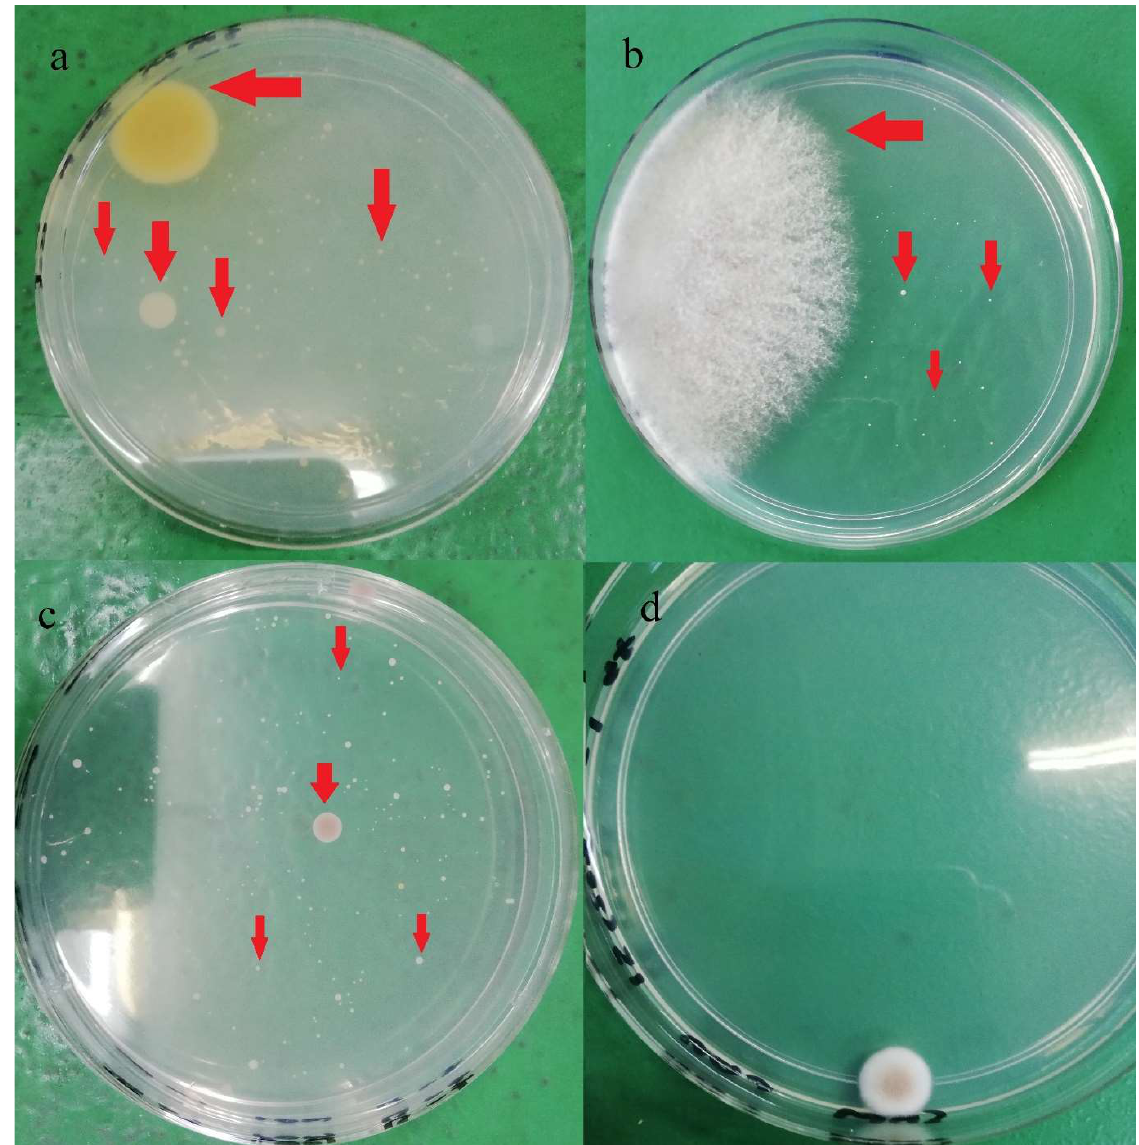
Figure 2. Different yeasts and molds colonies (red arrow) observed on PDA after five days incubation at 28 °C: ( a ) brand A, ( b ) brand B, ( c ) Brand C, ( d ) Brand D.